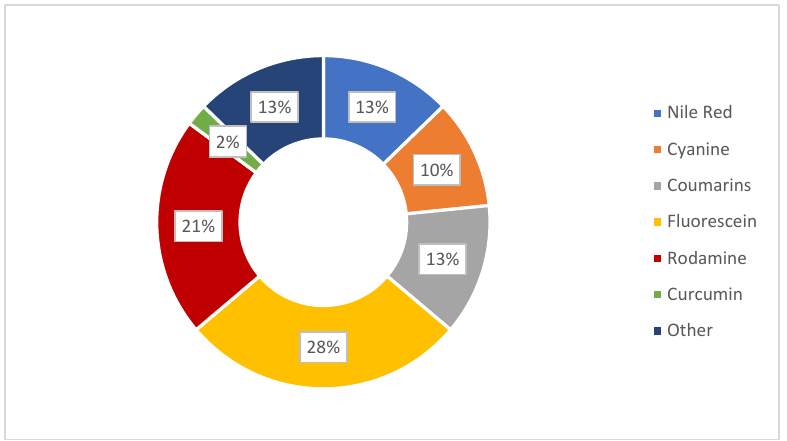
Figure 4. Graphical analysis of the fluorescent probes discussed in this review.